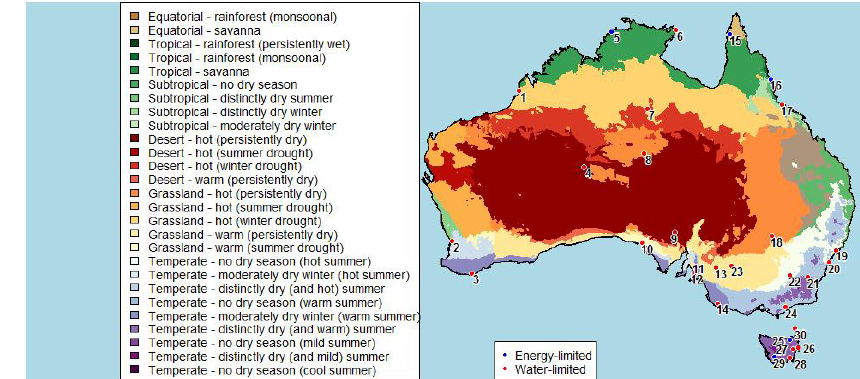
Figure 1. Locations of 30 Australian weather stations selected for analysis (see Table 1 for the full names of these weather stations), with reference to their corresponding climate classes derived following the modified Köppen classification (reproduced with data from Stern et al.,